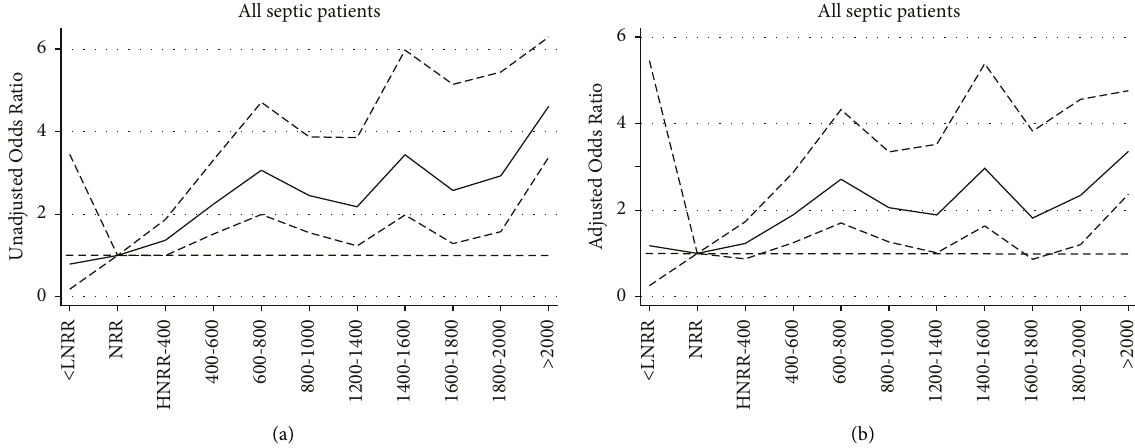
Figure 3: Te unadjusted (a) and adjusted odds ratios (ORs) of in-hospital mortality with patients in normal reference range (NRR) as the reference in the entire cohort of septic patients. Tis fgure shows that high ferritin was associated with a higher risk of in-hospital mortality in septic patients. Te decrease in serum ferritin had no infuence on the risk of in-hospital mortality. NRR for males � 30–400 ng/mL; NRR for females � 13–150ng/mL; LNRR: the lower limit of NRR; UNRR: the upper limit of NRR.